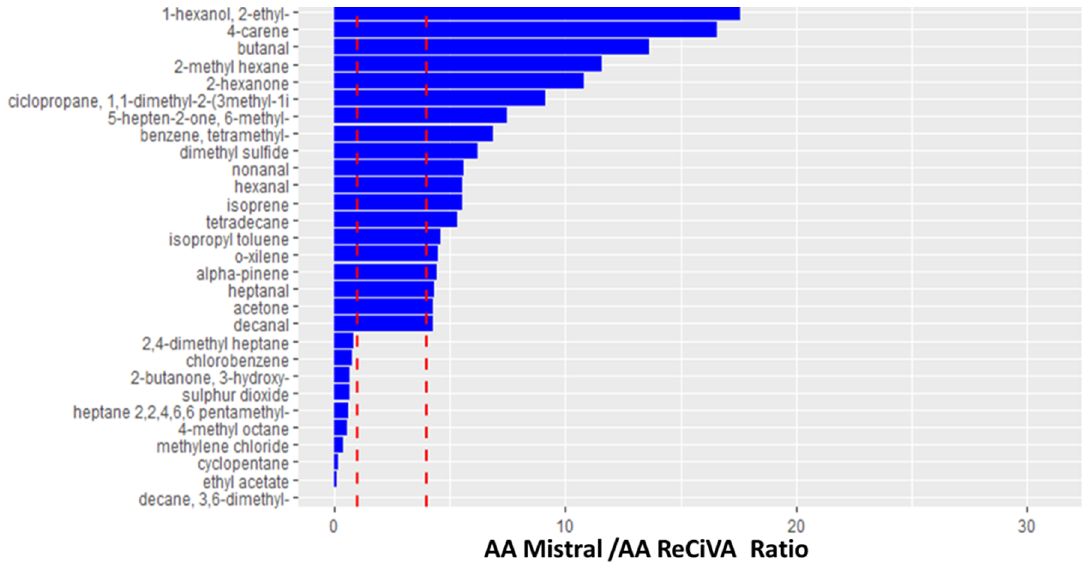
Figure 4. Ratio values between a normalized peak area of VOCs significantly different at a 95% of significance, in Ambient Air samples collected by using Mistral and ReCIVA devices. Red dashed lines represent a ratio value equal to 1 and 4, respectively.